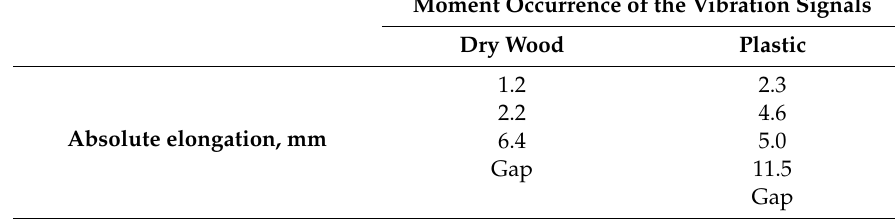
Table 2. Quantitative values of absolute elongation corresponding to the occurrence moments of vibration signals for dry wood and plastic.